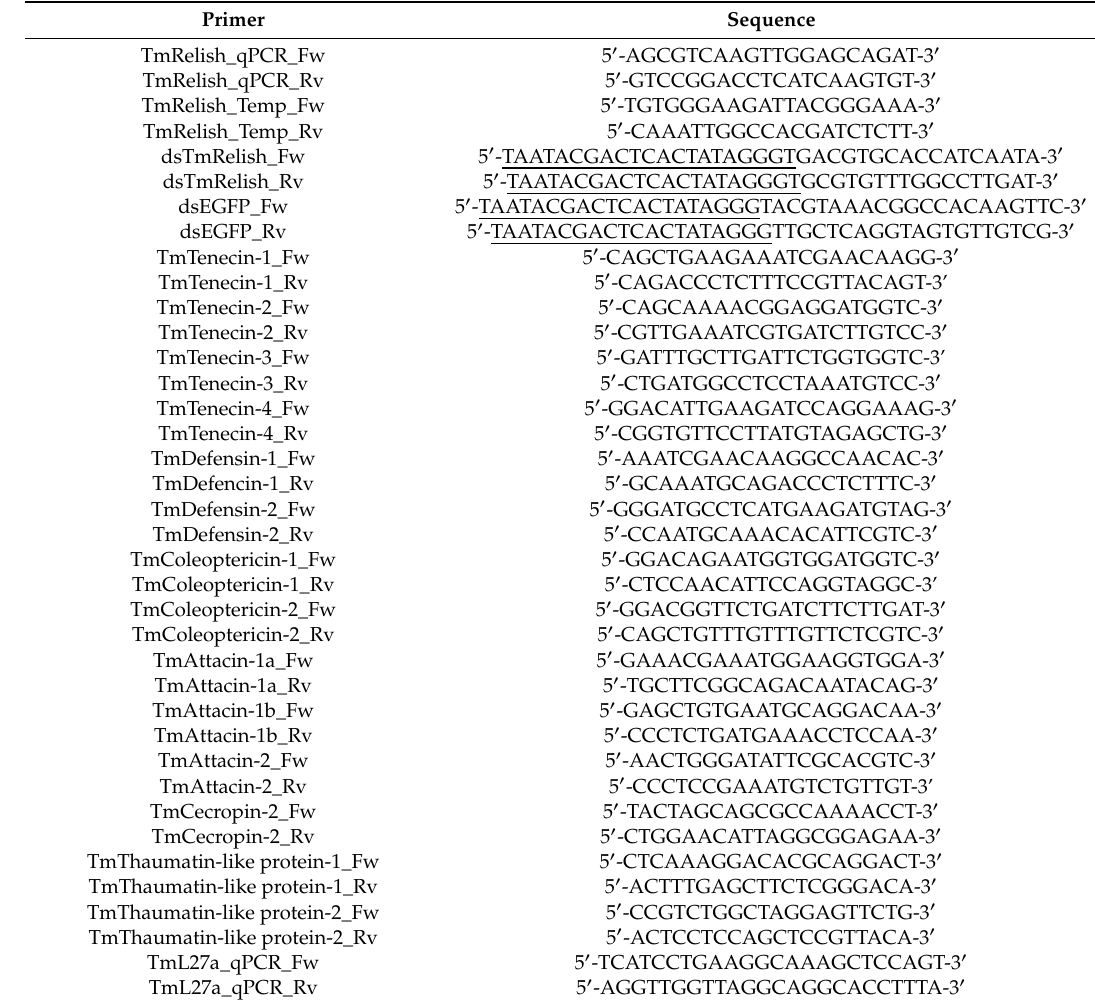
in Table 1. qRT-PCR data were analyzed using the comparative C T method (2 - Statistical analysis of fold change values was performed using a Student’s t-test ( p < 0.05). Table 1. Sequences of the primers used in this study.